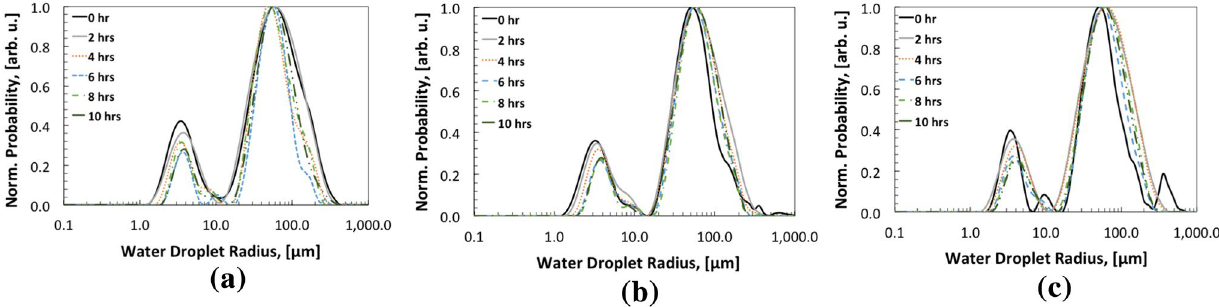
Fig. 8 Droplet size distributions for: a top, b middle and c bottom physical locations of water-in-oil emulsion formulated with AA-1 obtained from the PFG NMR diffusion experiments. Two populations of water represent small droplets and relatively free water phase